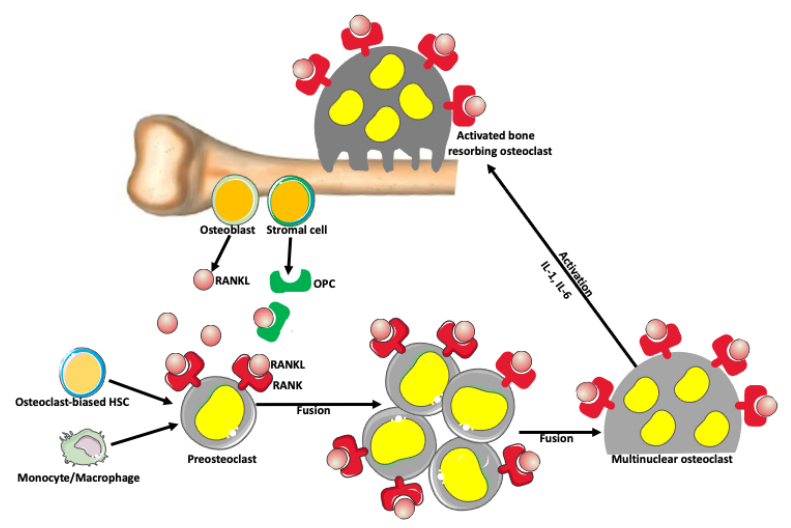
Figure 3. Osteoclast formation. There is a balance between bone-forming and bone-resorbing activities in normal conditions. The bone-resorbing cells’ osteoclasts form through the fusion of preoste- oclasts, which are derived from monocytes/macrophages and/or osteoclast-biased hematopoietic stem cells (HSC). Osteoblasts and stromal cells in the bone produce a receptor activator of nuclear factor-kappa- Β ligand (RANKL), which belongs to a tumor necrosis factor family of proteins. RANKL binds to its receptor RANK expressed on the surface of preosteoclasts and osteoclasts, pro- moting fusion and formation of syncytial multinuclear osteoclasts. After further activation by vari- ous cytokines, mature osteoclasts acquire a bone-resorbing activity. Osteoblast and stromal cells also produce osteoprotegerin (OPC) that prevents excessive bone resorption by binding to and de- pleting RANKL. Thus, RANKL/OPC ratio determines bone resorption or bone formation. 3.2. Langhans Giant Cells and Foreign Body Induced Giant Cells (FBGCs) Langhans giant cells (LGCs) (not to be confused with Langerhans cells) first de- scribed in tuberculosis [65] are MGCs containing a characteristic horseshoe-shaped ring of nuclei. LGCs are present within every form of granuloma, regardless of infectious or non-infectious etiology [66–69]. It is believed that LGCs play a role in restricting the path- ogen/compound within the host. [69]. Foreign body-induced MGCs (FBGCs) form in re- sponse to large organic and inorganic compounds and surgical implants [67,70,71]. FBGCs are specifically adapted for phagocytosis and removal of large (above 45 μ m diameter) particles, which individual macrophages cannot eliminate [67]. 4. Tumor-Associated Macrophages (TAMs) and Cell Fusion in Cancer Tumor-associated macrophages (TAMs) are a significant component of tumors, ac- counting for 30–50% of a tumor mass. In many cancers, a high density of TAMs correlates with poor patient prognosis and survival. There are two primary sources of TAMs. One is the reprogramming of tissue-resident macrophages to TAMs by the tumor milieu. An- other is the recruitment of circulating monocytes into the tumor, where they differentiate into TAMs [72–74]. One of the theories of tumor progression and metastasis states that TAMs and other cells of myeloid origin fuse with cancer cells, allowing them to acquire motility and metastasize [52,53,75–77]. Macrophage fusion in breast cancer was recapitu- lated in cell culture. Shabo et al. [52] observed spontaneous fusion between M2 macro- phages and GFP-labeled MCF-7 cancer cells. Hybrid cancer cells expressed macrophage- specific antigen CD163, which correlates with poor survival in cancer patients. The same group [53] suggested that the formation of multinucleated fusion hybrids salvages the loss of gene function/DNA damage caused by chemotherapy or radiation, allowing hybrid